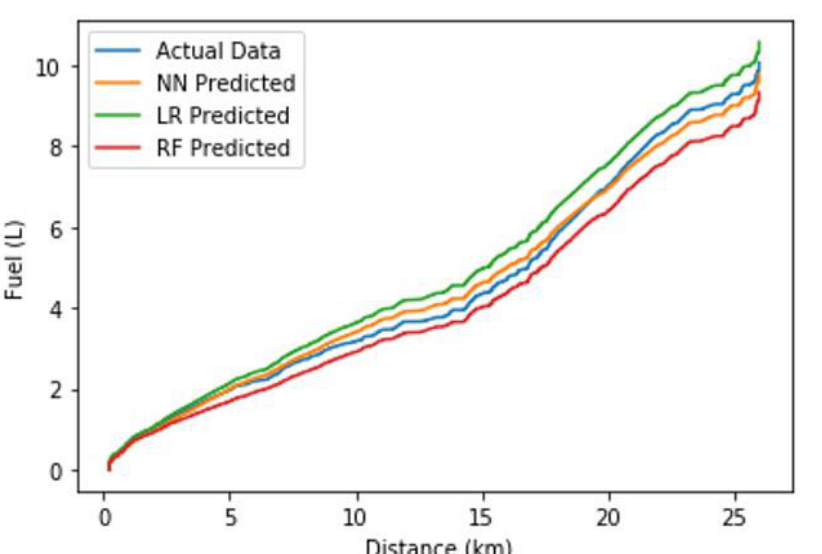
Figure 6. Comparison of total fuel consumed with different models.